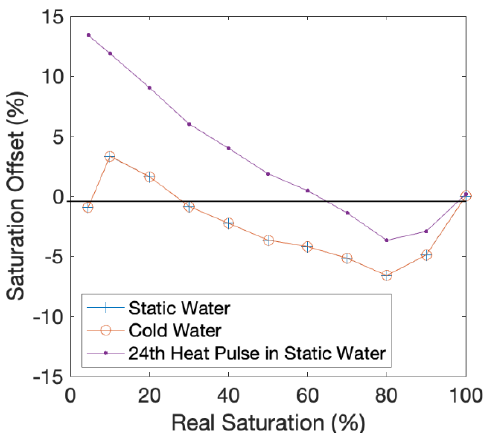
Figure 2. Static Simulations: The plot displays the effects of cold-water infiltration, and the cumula- tive effect of repeated hourly heat pulses on the accuracy of the protocol calculation. Real saturation refers to the saturation that is prescribed with the model setup.